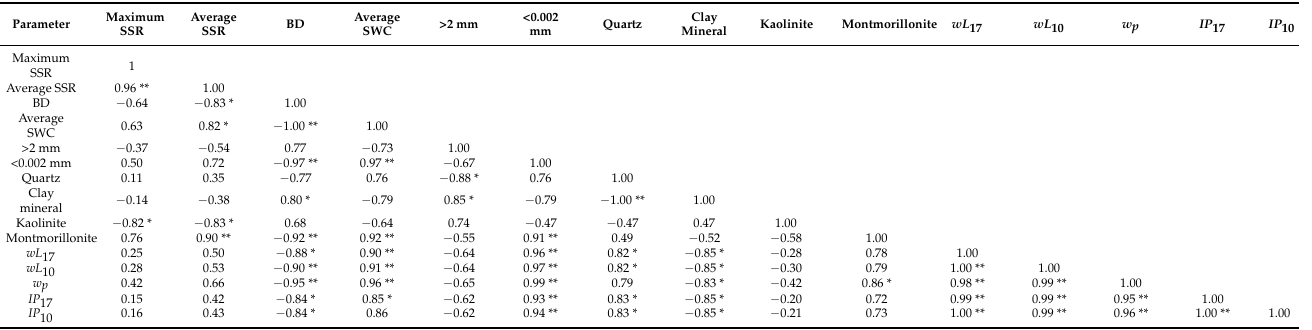
Table 2. Correlation coefficient of shrink–swell ratio and the other 12 soil